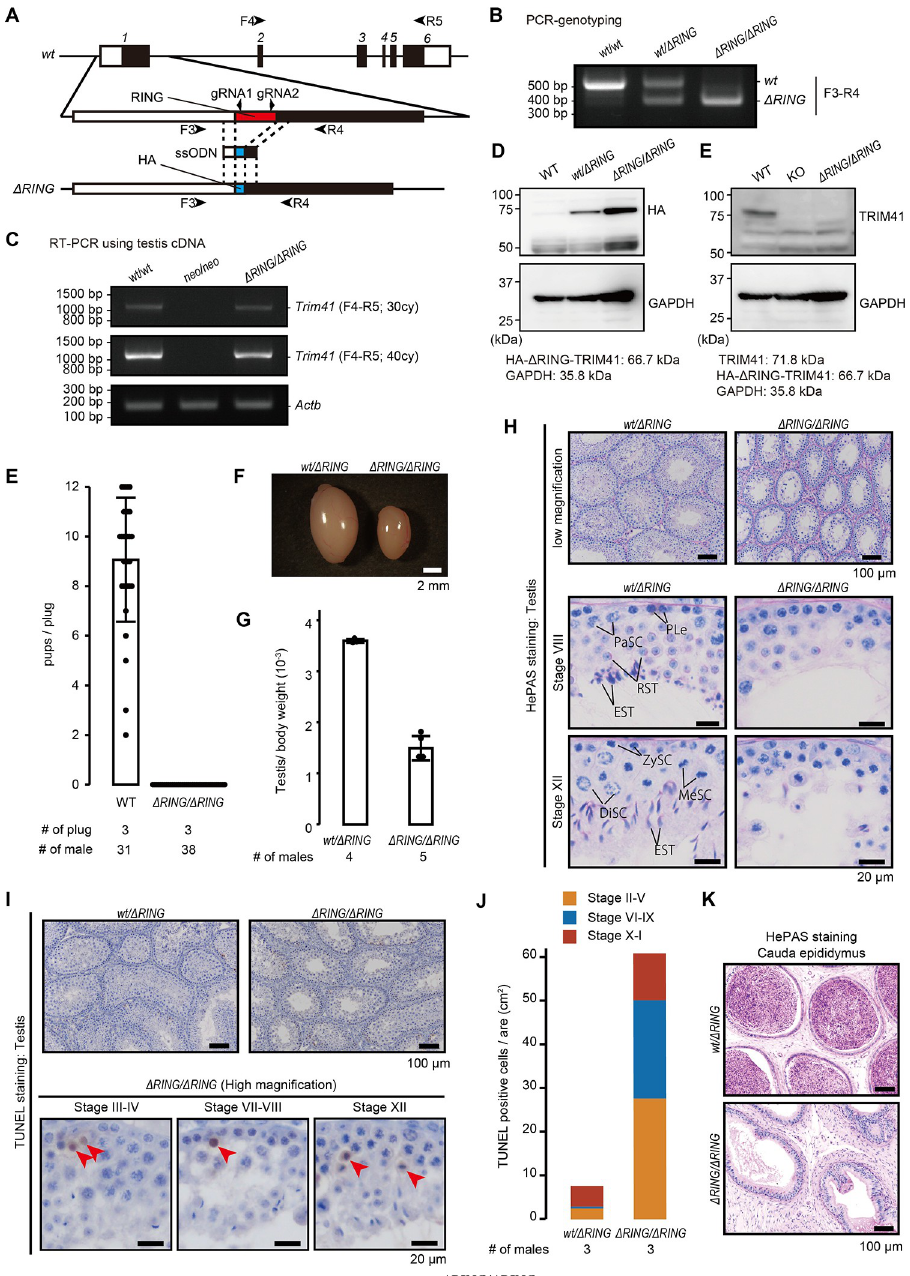
Fig 6. Production and phenotypic analysis of Trim41 Δ RING/ Δ RING mice. (A) Knock-in scheme for the replacement of the RING domain with the HA tag. Black and white boxes in the gene map indicate coding and non-coding regions, respectively. Black arrowheads (F3, R4, F4, and R5) and arrows (gRNA1 and gRNA2) indicate primers for genotyping and target sequence of gRNAs, respectively. (B) An example of genotyping PCR with primer sets in A (F3 and R4). (C) RT-PCR using testis cDNA and primer sets in A (F4 and R5). Actb was used as a loading control. (D and E) Immunoblotting analysis with anti-HA (D) and -TRIM41 (E) antibodies. Black and red arrows indicate TRIM41 and Δ RING-TRIM41, respectively. (F) The result of mating tests. Pups/plug: 9.1 ± 2.5 [WT]; 0 [ Trim41 Δ RING/ Δ RING ] (s. d.). Error bars indicate standard deviation. The numerical data are available in S3 Table (G and H) Testis morphology (G) and testis/bodyweight of Trim41 wt/ Δ RING and Trim41 Δ RING/ Δ RING adult mice (H). Error bars indicate standard deviation. The numerical data are available in S3 Table (I) PAS staining of seminiferous tubules of adult mice. The seminiferous epithelium cycle was determined by germ cell position and nuclear morphology. PLe: Preleptotene stage spermatocyte; ZySC: Zygotene stage spermatocyte; PaSC: Pachytene stage spermatocyte; DiSC: Diplotene stage spermatocyte; MeSC: metaphase spermatocyte; RST: round spermatid; EST: elongating/elongated spermatid. At